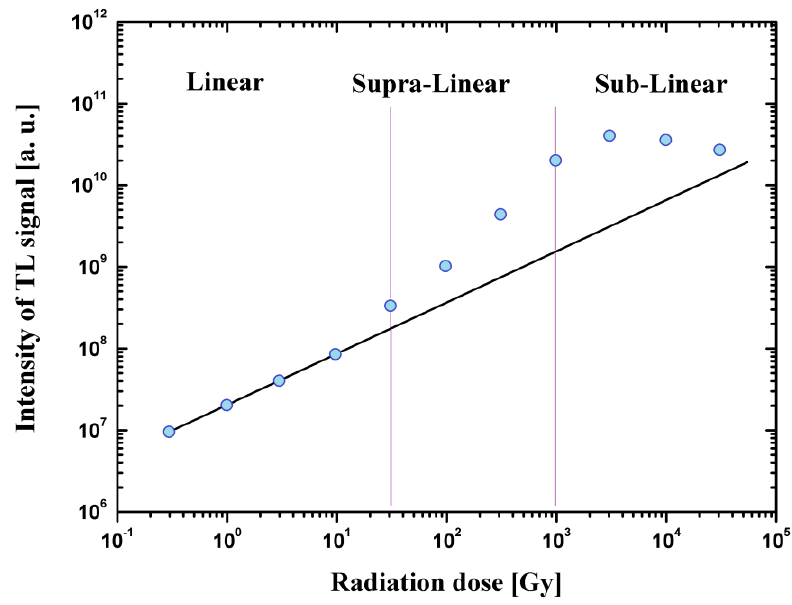
Figure 3. An example of the linear, super-linear and sub-linear thermoluminescence signal as a function of the absorbed dose [124].